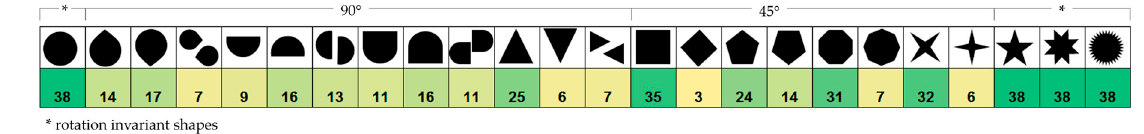
Figure 5. Shape orientation scheme and frequencies of shape rotations according to the set of 12 geometric shapes (N = 38).